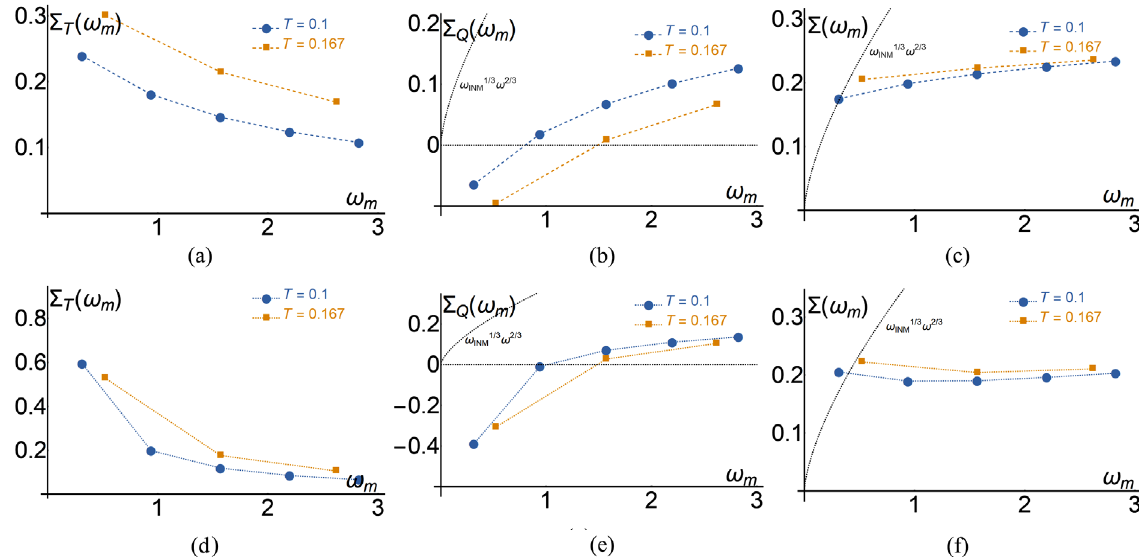
FIG. 8. The fermionic self-energy for the Ising-nematic model. (a) – (c) Dashed traces: Fermionic self-energy from MET, showing the (a) thermal, (b) quantum, and (c) total self-energy. The black dashed lines on the right are the asymptotic T ¼ 0 prediction of ET. (d) – (f) Dotted traces: Fermionic self-energy from